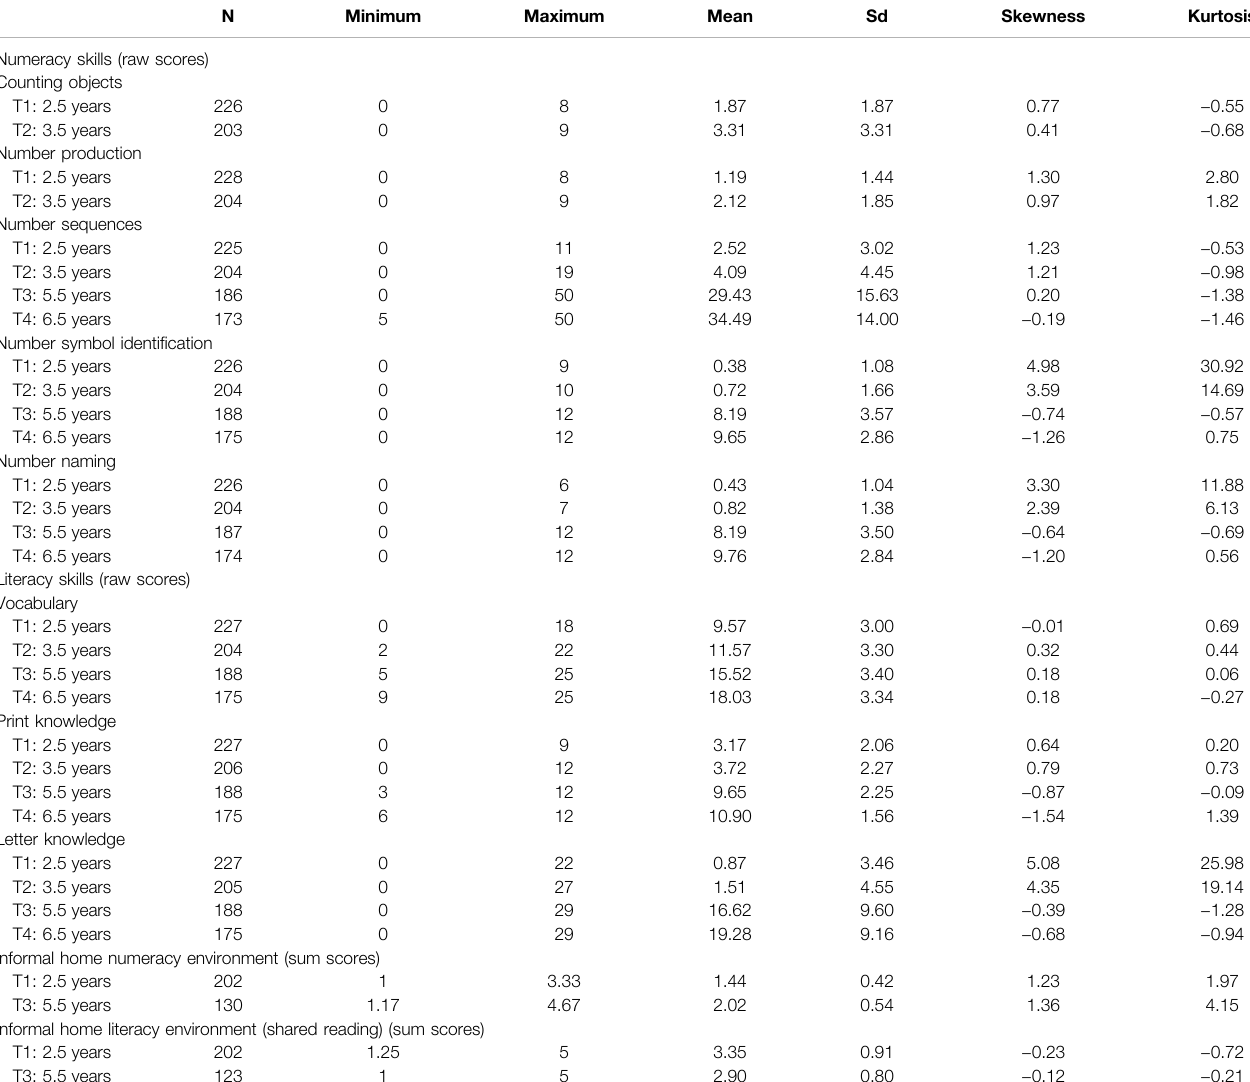
TABLE 1 | Descriptive statistics for all variables across time. N Minimum Maximum Mean